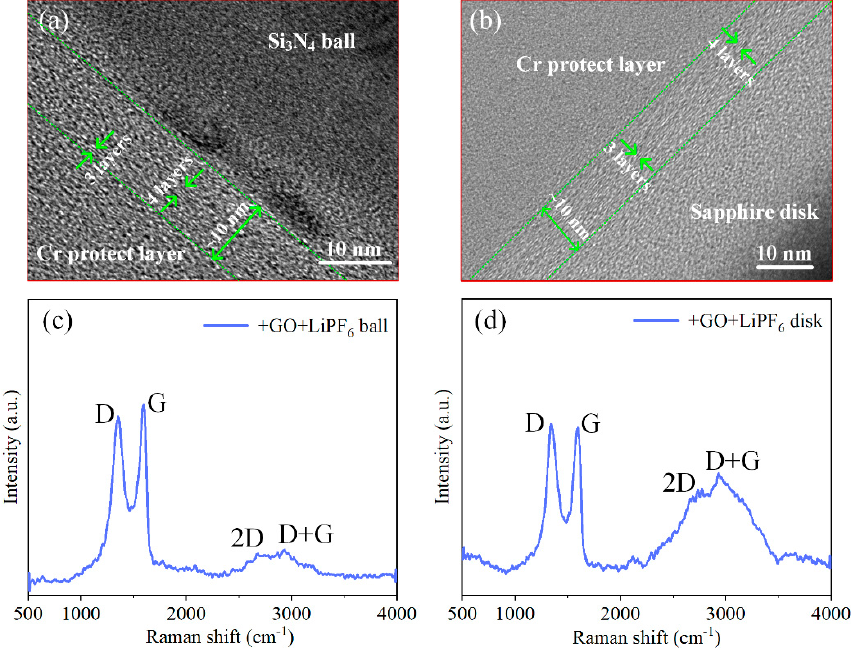
Figure 7. ( a , b ) HRTEM images of GO adsorption layer on worn surfaces. ( c , d ) Raman spectra of GO adsorption layer on worn areas.